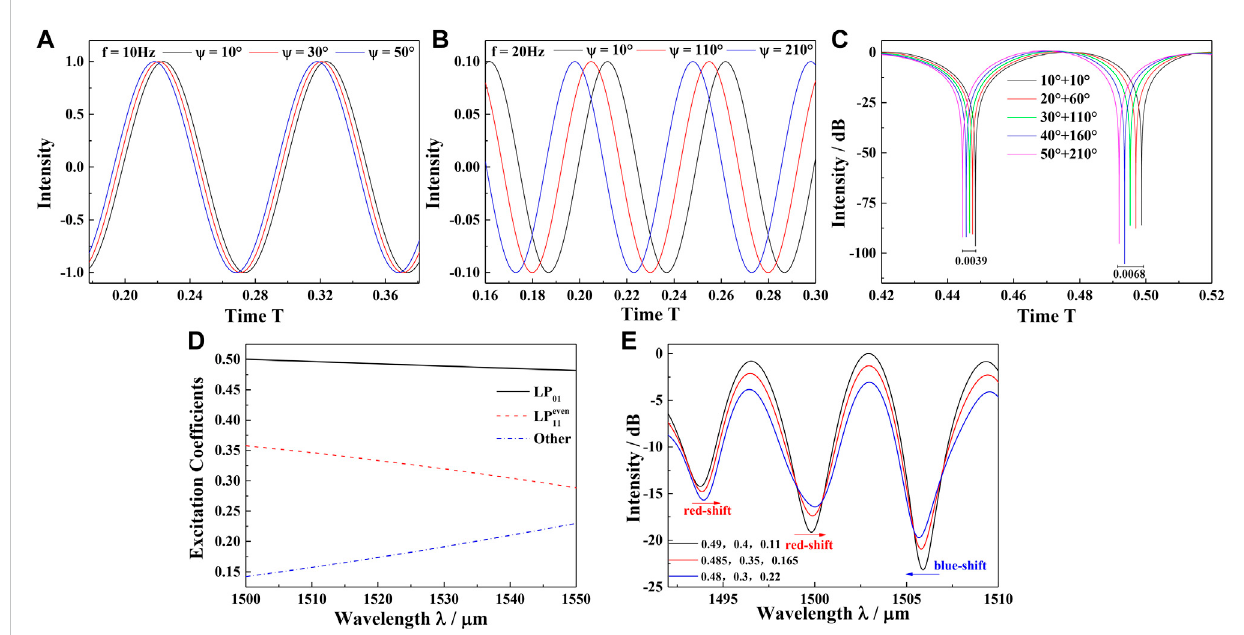
The mechanism analysis of the spectra shift, (A) , (B) , (C) the different sensitivities of the dips as the variation of the ψ ; (D) , (E) the different shift directions as the variation of the excitation coef fi